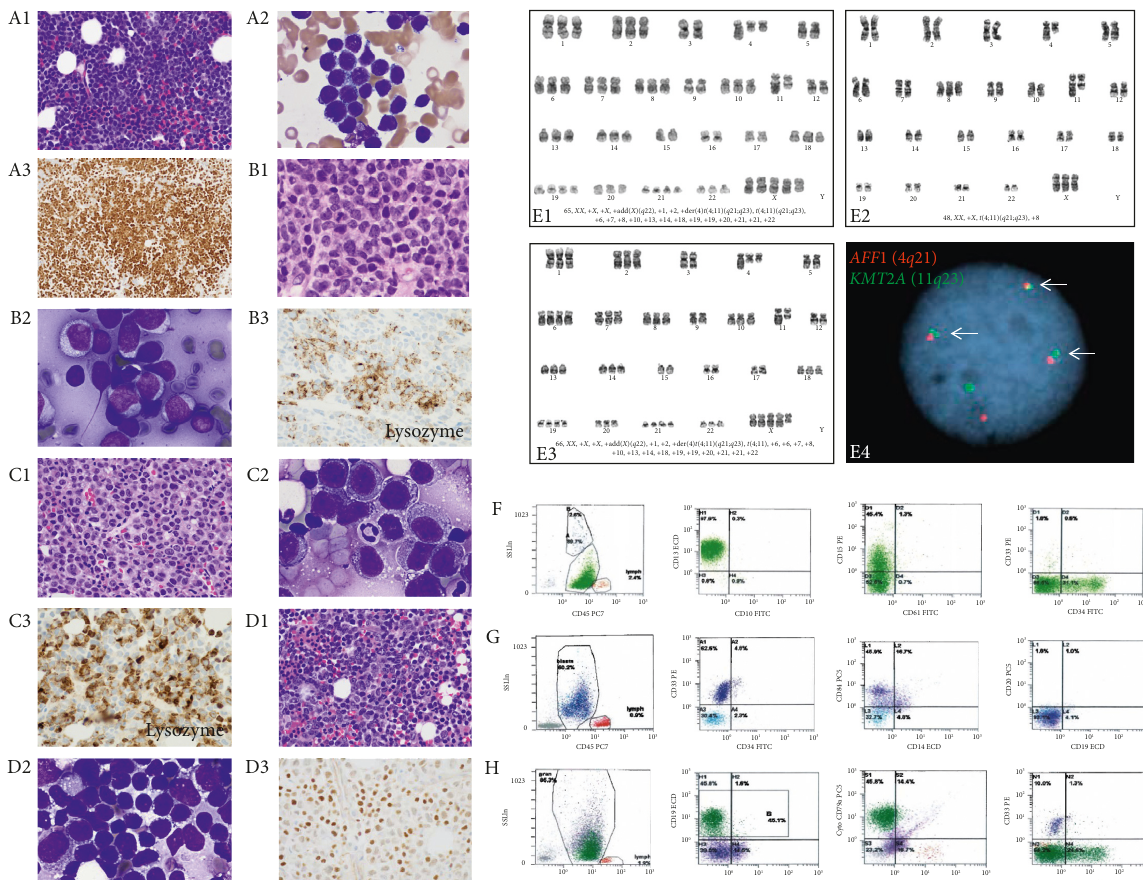
Figure 1: Morphologic, immunohistochemical, flow cytometric, and cytogenetic characteristics of the patient’s leukemia. A1–A3 represent bone marrow evaluation at initial diagnosis. Bone marrow biopsy (A1, H&E, 400x) and aspirate (A2, Wright stain 100x, oil) showing numerous small-sized B-lymphoblasts which are strongly positive for PAX5 (A3). B1–B3 represent biopsy of the breast mass (B1, H&E, 400x) and touch imprint (B2, Wright stain, 100x, oil) showing numerous large-sized blasts with monocytic differentiation, which are patchy positive for lysozyme (B3). C1–C3 represent bone marrow biopsy (C1, H&E, 400x) and aspirate (C2, Wright stain, 100x, oil) showing sheets of myeloblasts which are patchy positive for lysozyme (C3). D1–D3 represent bone marrow evaluation six weeks after cessation of bli- natumomab. Core biopsy (D1, H&E, 400x) and aspirate (D2, Wright stain, 100x, Oil) show a dimorphic population of blasts: small-sized B- lymphoblasts which are positive for PAX5 (D3) and large-sized myeloblasts which are positive for lysozyme (data not shown here). E1 represents the karyogram of bone marrow specimen at myeloblastic transformation. E2–E4 represent karyograms and AFF1/KMT2A fusion of bone marrow specimen with B/myeloid mixed phenotype acute leukemia. F–H represent flow cytometric features of the leukemic blasts. F represents flow cytometry performed on the bone marrow aspirate at the initial diagnosis showing a large population of B-lymphoblasts (green) in dim CD45 region expressing CD19, CD34 (partial), and CD15 (dim), G represents flow cytometry of the bone marrow aspirate while administration of blinatumomab showing a population of myeloblasts (blue) expressing CD33 and CD64 (dim) and was negative for CD19 and CD34. H represents flow cytometry of the bone marrow aspirate six weeks after cessation of blinatumomab showing two populations: B-lymphoblasts (green) expressing CD19, CD34 (dim), and cytoCD79a, and myeloblasts (blue) expressing CD33, CD64 (dim), and MPO (data not shown here). Table 1: Genetic results obtained at the time of B-ALL diagnosis, transformation to AML following initiation of blinatumomab therapy, and subsequent posttransformation to MPAL upon discontinuation of blinatumomab. Transformation: MPAL (04/18/ Genetic testing Diagnosis: B-ALL (10/26/2018) Transformation: AML (02/25/2019) 2019) Conventional chromosome analysis AFF1/KMT2A fusion (92% of 500 KMT2A rearrangement (93% of 100 Not performed FISH interphase nuclei) interphase nuclei) B-ALL, B-acute lymphoblastic leukemia; AML, acute myeloid leukemia; MPAL, mixed phenotype acute leukemia; FISH, fluorescence in situ